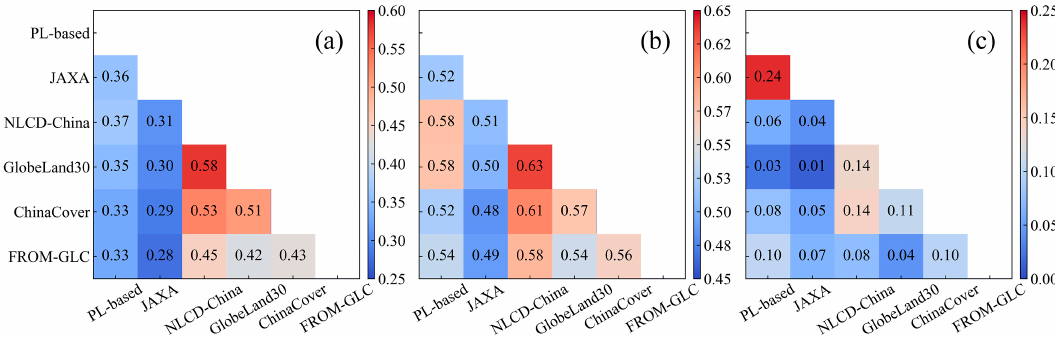
Figure 10. The spatial consistency index values among the six forest maps in the: ( a ) North China Plain (NCP); ( b ) mountain region; and ( c ) plain region.